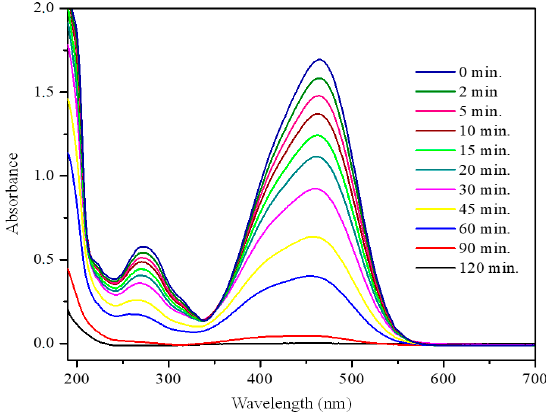
Figure 6. Photocatalytic degradation of methyl orange over commercial TiO 2 (Aeroxide ® TiO 2 P25 Evonik) as a function of the reaction time.